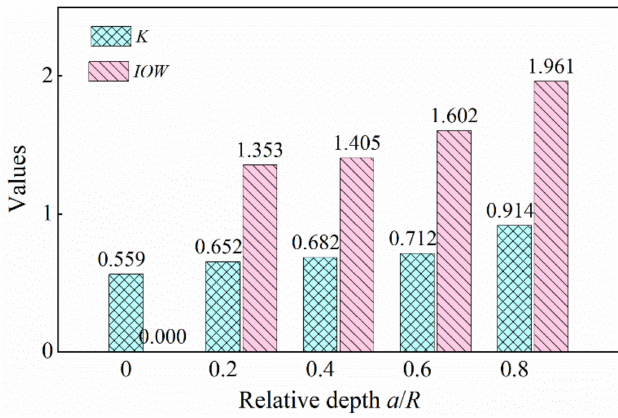
Figure 15. The values of IOW and K in the